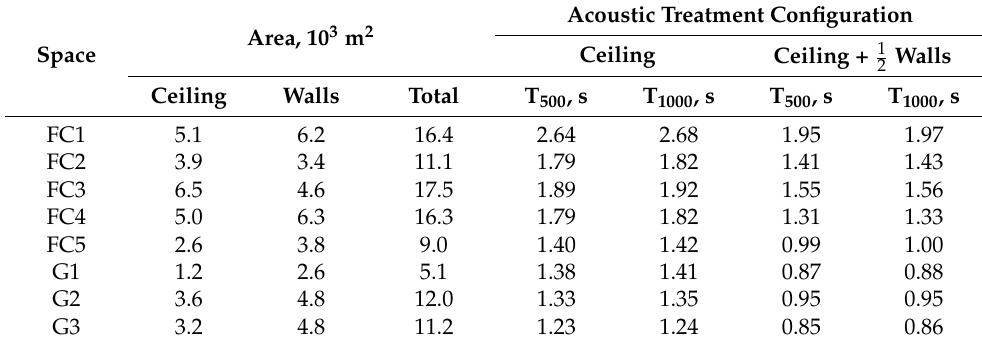
Table 8. Calculated reverberation time due to acoustic